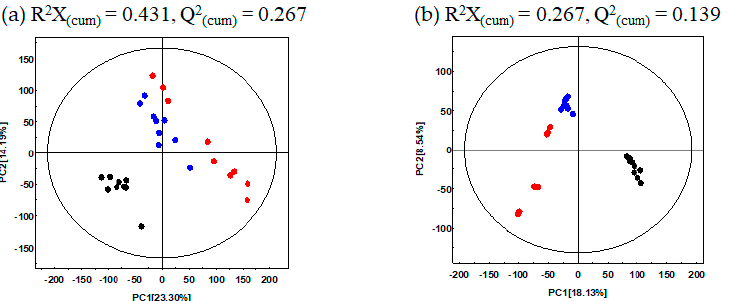
Figure 1. PCA score plots of Ginseng berry pomace (GBP) obtained after different ultra-high-pres- (UHP) processing treatments and analysis by ( a ) GC-TOF-MS; ( b )